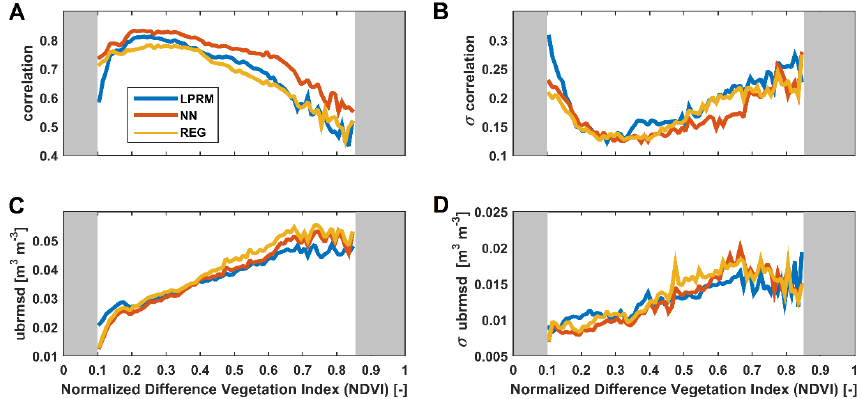
Figure 2. Comparison of the three different fusion methods of AMSR-E against SMOS, in terms of correlation ( A ), the standard deviation of the correlation ( B ), ubrmsd ( C ) and standard deviation of the ubrmsd ( D ) binned over NDVI. NDVI < 0.1 is masked due to too not enough precipitation events (e.g., in the R value technique), NDVI > 0.85 is masked as satellite-retrieved soil moisture loses skill over too dense vegetation.